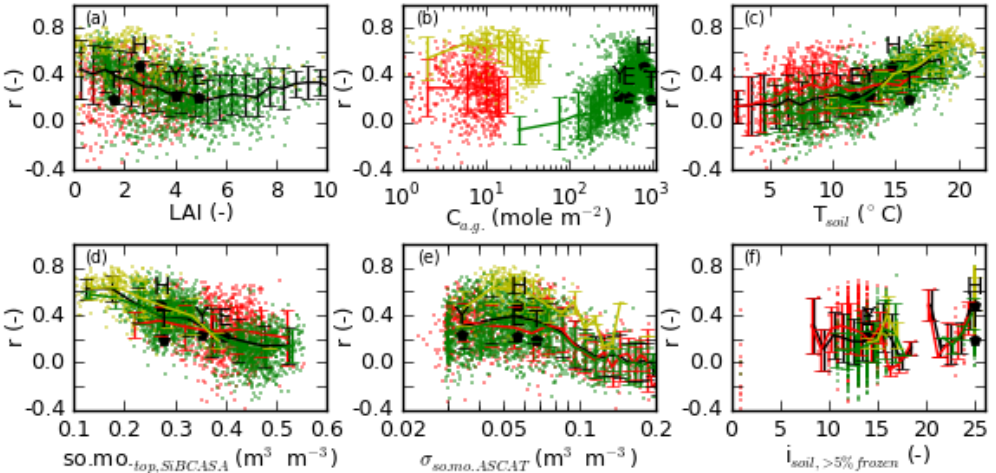
Figure 12. Variables possibly explaining the temporal correlation coefficient of SiBCASA and ASCAT soil moisture: (a) leaf area index; (b) aboveground carbon; (c) soil temperature; (d) top soil moisture in SiBCASA; (e) the uncertainty in ASCAT soil moisture; (f) the first soil layer with frozen fraction larger than 5%. Red colours represent tundra pixels, green ones forest pixels, and yellow dots steppe pixels. The r represents the correlation coefficient between SiBCASA and ASCAT in all August days in the period of record (31 days × 7 years). The four black marks indicate the characteristics of the four sites Hyytiälä (H), Tver (T), Yakutsk (Y) and Elgeeii